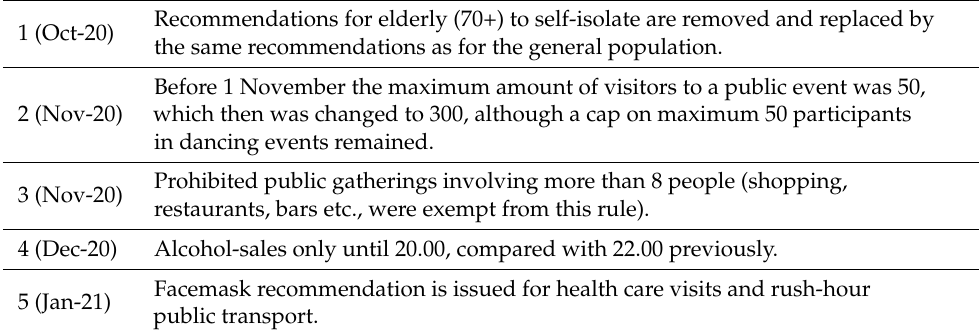
Figure 2. ( Left ): 7-day rolling average of new cases in Stockholm county, adjusted to match the reported increase in seroprevalence of antibodies against SARS-CoV-2. The numbers 1–5 cor- respond with the updates to the NPIs in Table 1. ( Right ): total cases separated in Wuhan-strain and Alpha-strain. Table 1. Summary of major updates to the NPIs in Sweden between September 2020 and May